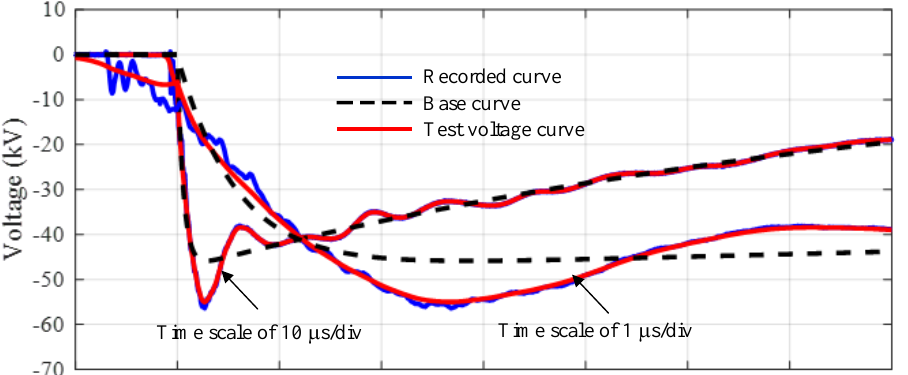
Figure 10. The assessed full lightning impulse waveforms in the LI-A7 case (waveform data pro- vided by [13]).